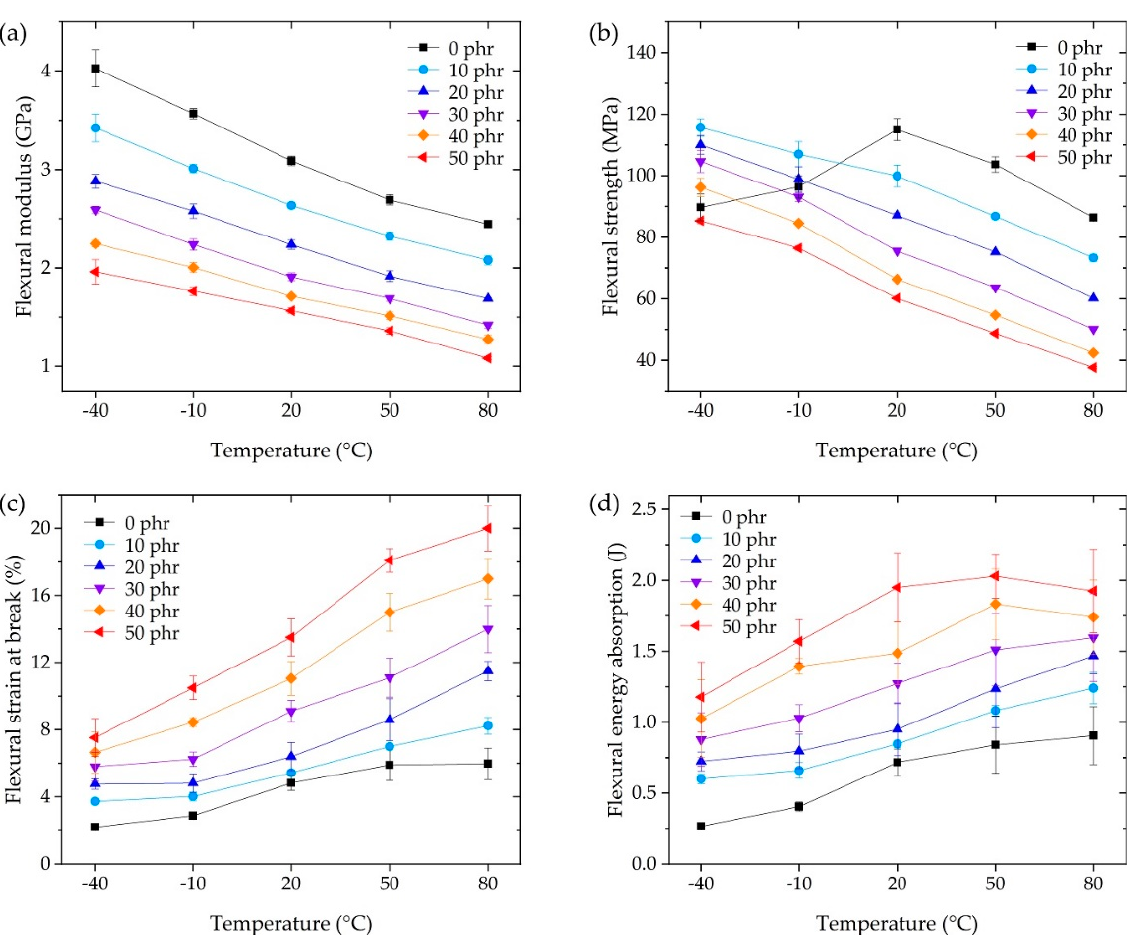
Figure 5. Three-point flexural tests at the operating temperature, showing the ( a ) flexural modulus, ( b ) flexural strength, ( c ) flexural strain at break, and ( d ) flexural energy absorption.